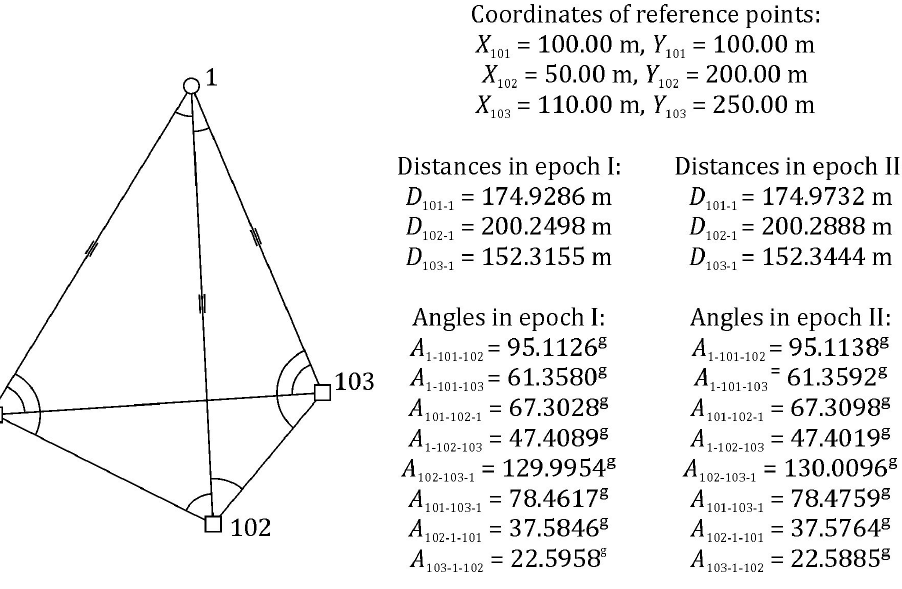
and α emp for HLWEs in horizontal network X 1 Y 1